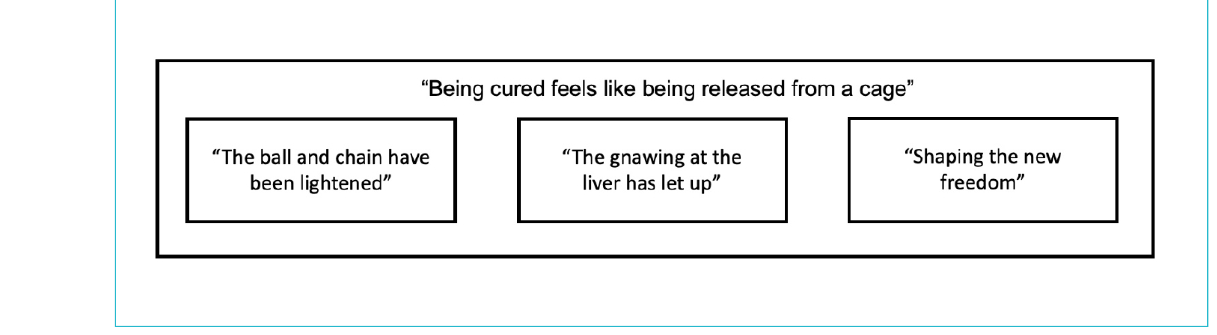
Figure 1: Overarching theme and sub-themes. The constitutive theme “Being cured feels like being released from a cage” described by re- counting experiences of three sub-themes: “the ball and chain have been lightened”; “the gnawing at the liver has let up”; and “shaping the new